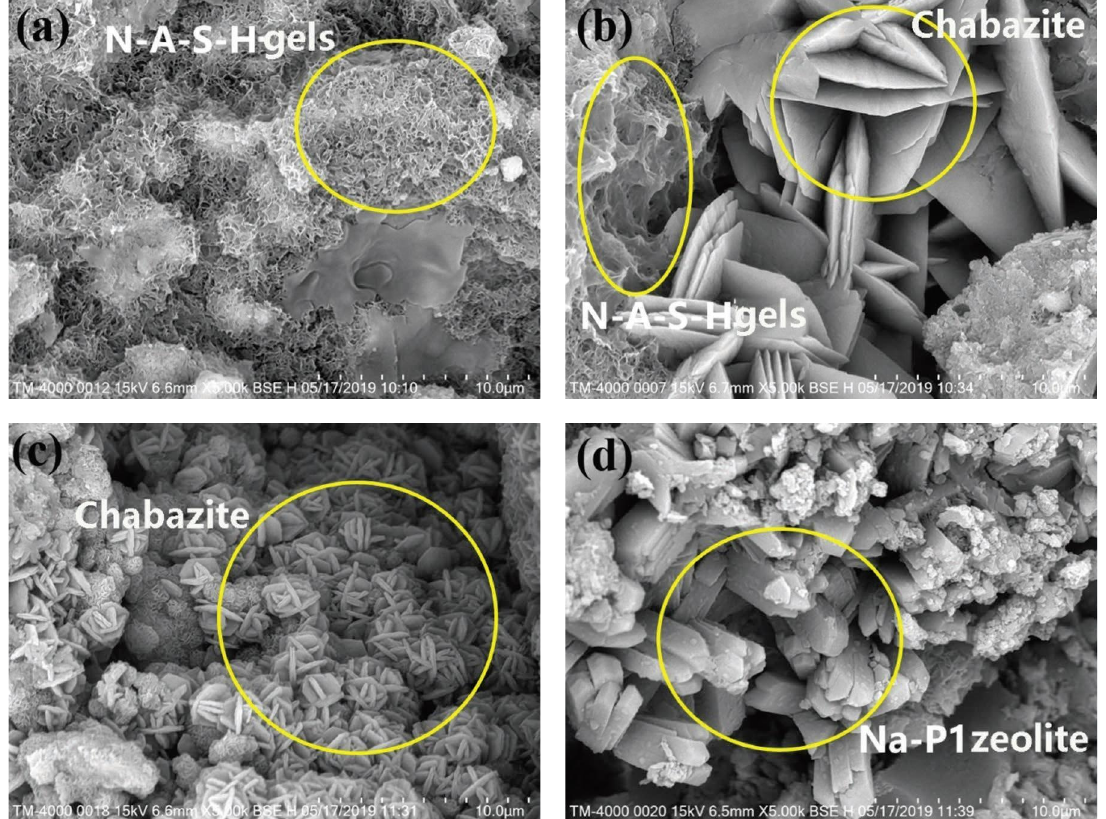
Figure 12: Te SEM images of the SFCM with diferent sodium hydroxide contents after curing at 90 ° C for 28 d. (a) 0.82%, 300g/L; (b) 5%, 300g/L; (c) 10%, 300g/L; and (d) 10%,